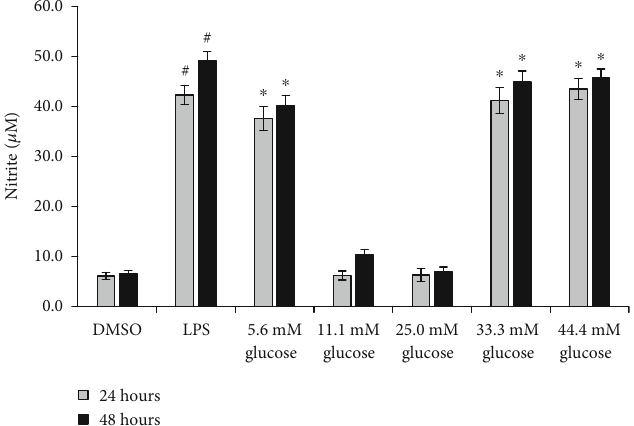
Figure 1: Determination of hyperglycemic conditions capable of inducing phenotypic transition of M1 macrophage. Values were expressed as mean ± standard error of the mean ( n = 6 ). # p < 0 : 05 versus DMSO after 24 hours ’ and 48 hours ’ treatment separately. ∗ p < 0 : 05 versus 11.1mM glucose after 24 hours ’ and 48 hours ’ treatment separately. Abbreviations: LPS: lipopolysaccharide; DMSO: dimethyl sulfoxide, the solvent control of LPS.